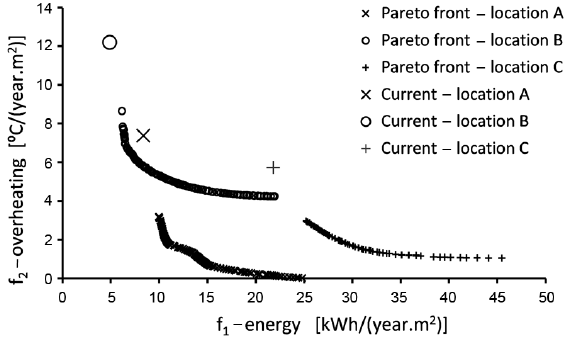
Fig. 5. Multi-objective optimization